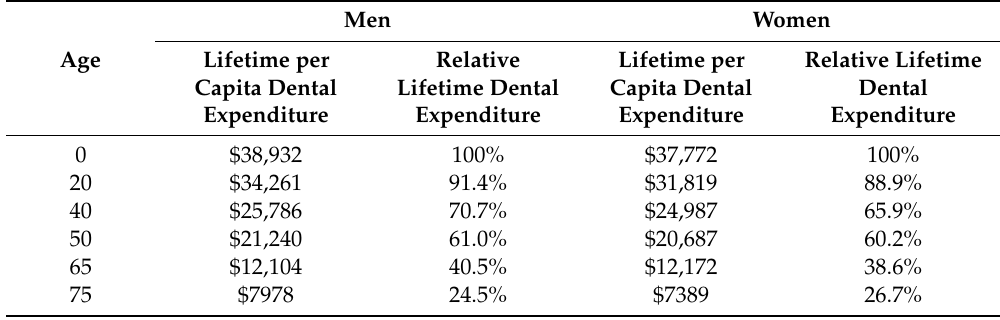
Table 3. Per capita lifetime dental expenditures of average life table and the relative lifetime dental expenditures for survivor men and women.